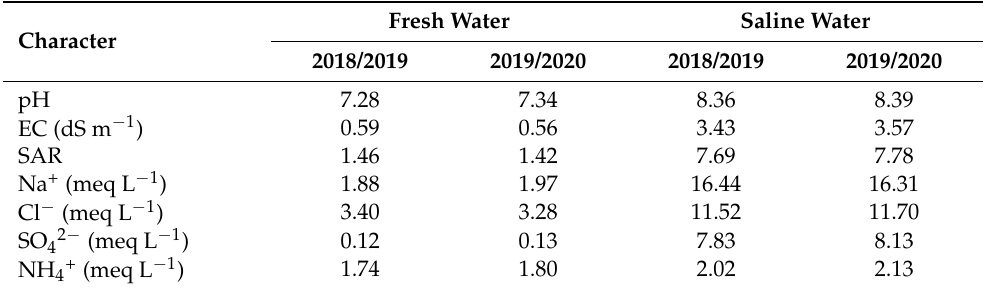
Table 3. Characteristics of irrigation water used in the two winter seasons 2018/2019 and 2019/2020.